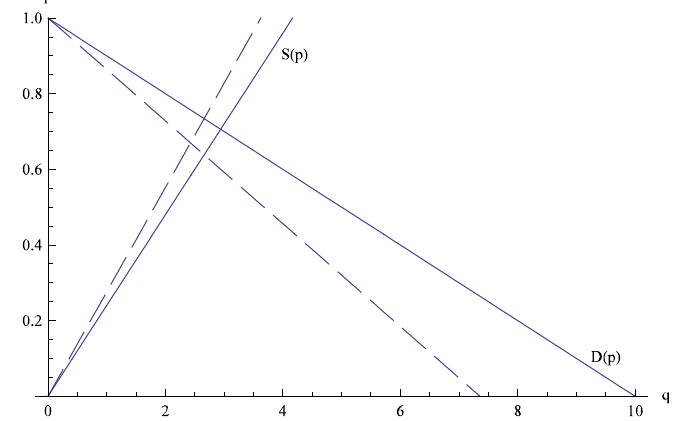
Fig. 2 Market equilibrium when all customers act independently (solid line) and when some of them create a buyer group (broken line). Parameter values: z (cid:4) 1.4 and s (cid:4)